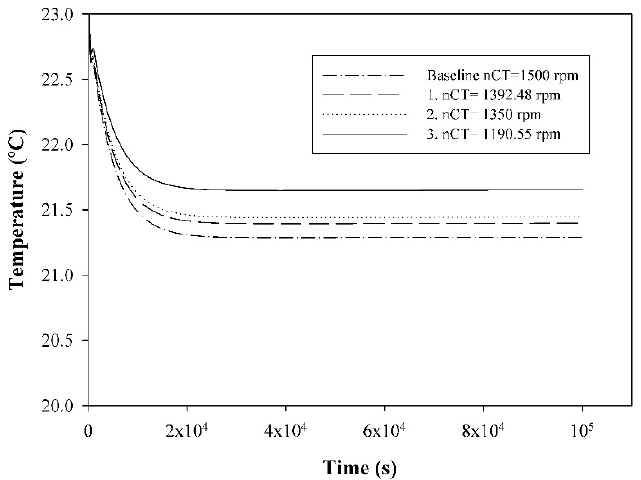
Figure 8. Influence of rotational speed of the cooling tower fans (nCT) on the water temperature of the cold water tank (T).